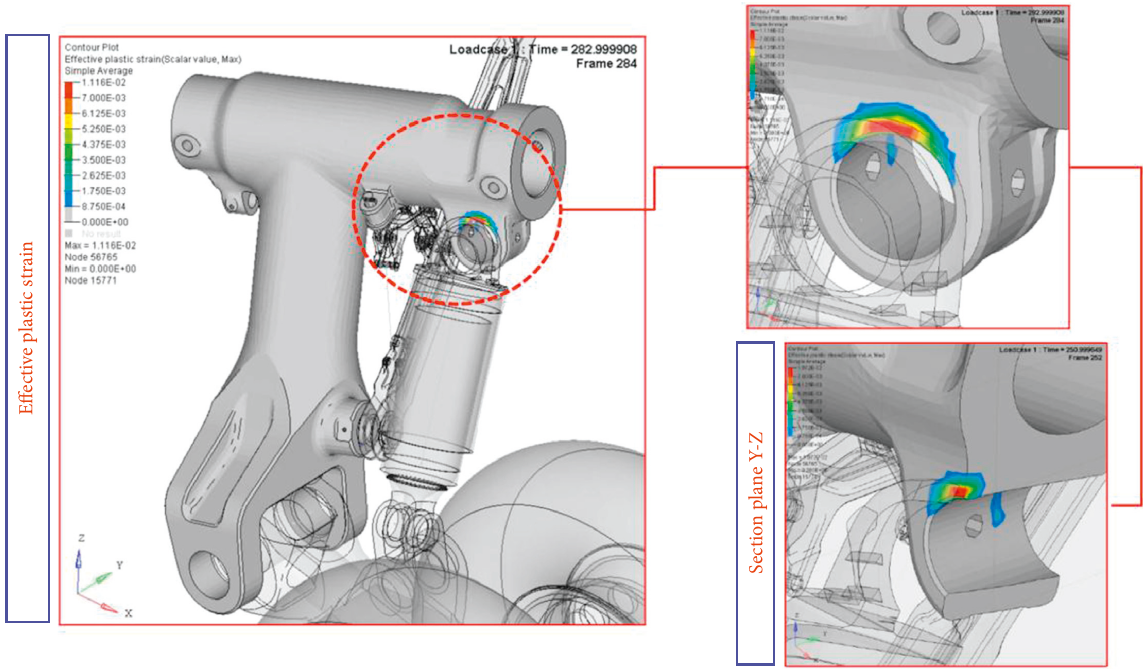
Figure 35: Effective plastic strain map for the main